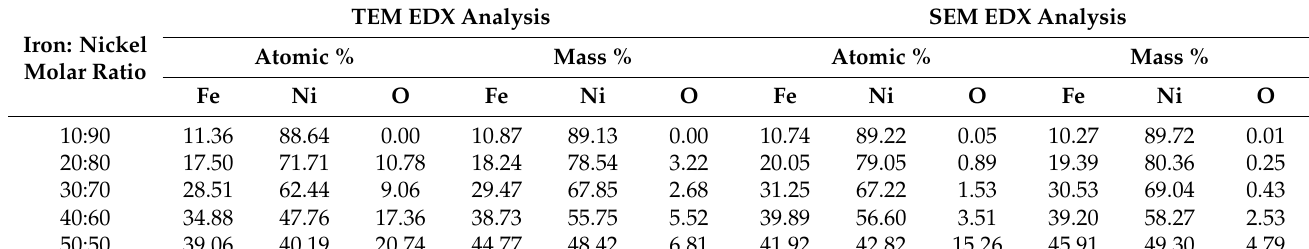
Table 1. EDX analysis of the synthesized five alloys equipped with TEM and SEM. Reaction reference: 0.1 M metal concentration, 80 mL reaction volume, 1400 rpm, and 95–98 ◦ C.